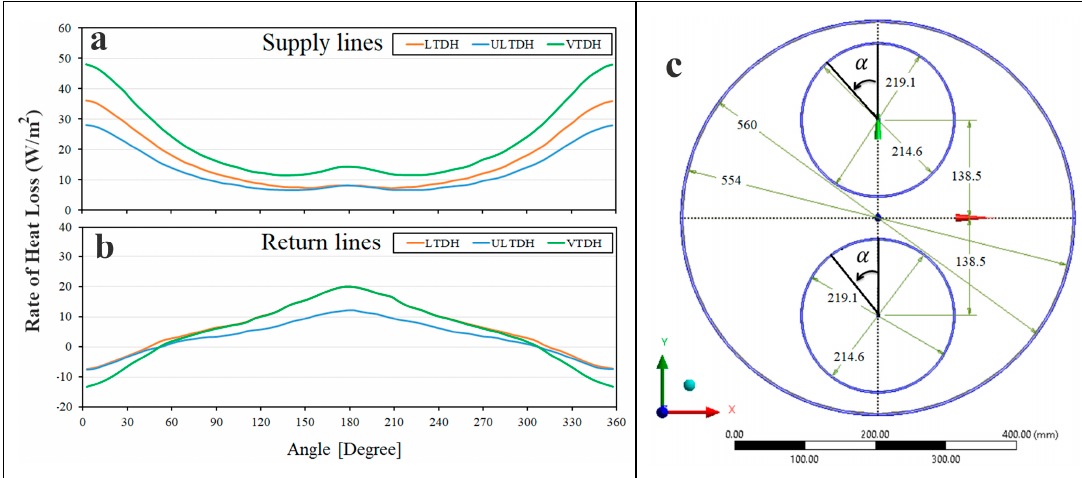
Figure 13. The rate of heat loss from the supply and return pipes as a function of angle in each case. ( a ) supply lines; ( b ) return lines; ( c ) pipe dimensions and angles. ( a ) supply lines; ( b ) return lines; ( c ) pipe dimensions and